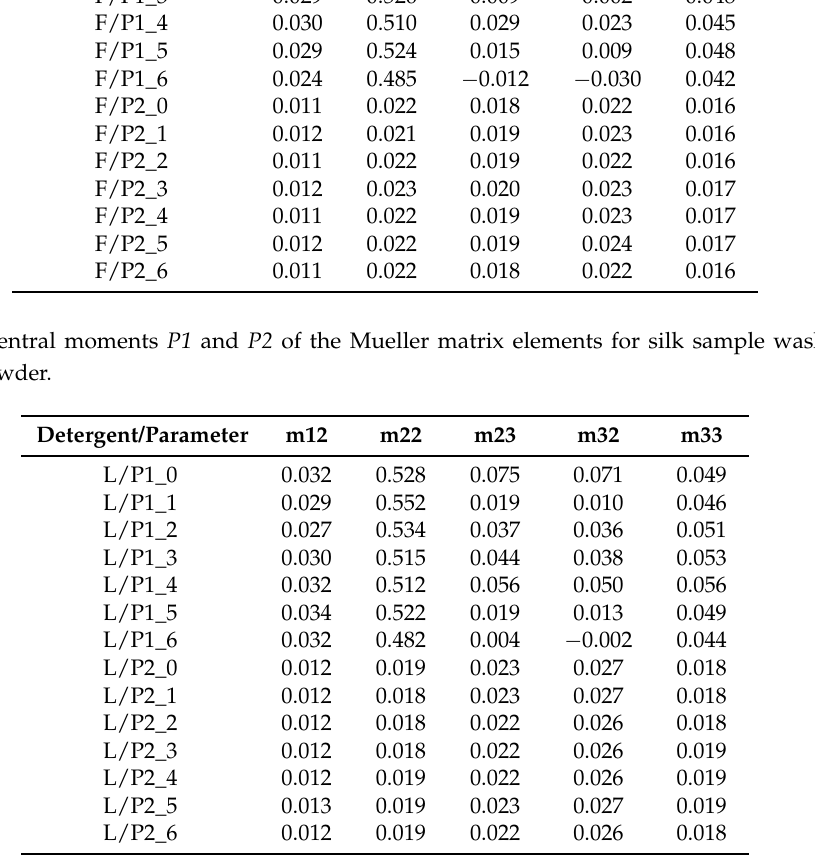
Table 3. Central moments P1 and P2 of the Mueller matrix elements for silk sample washed by toilet